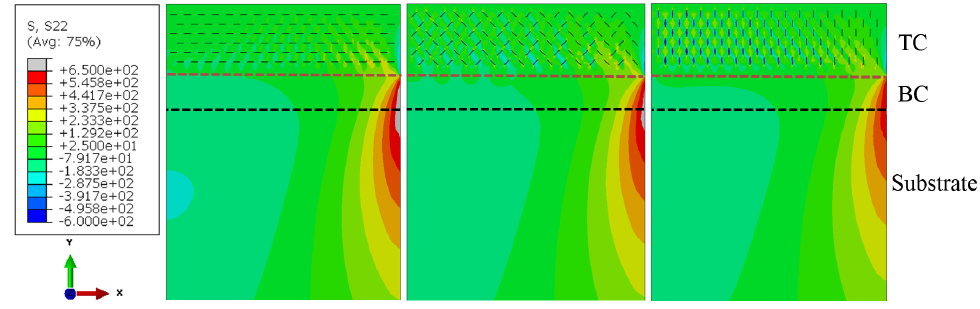
Figure 12. Thermal stress distribution in TBC system with different pore structure during quenching.